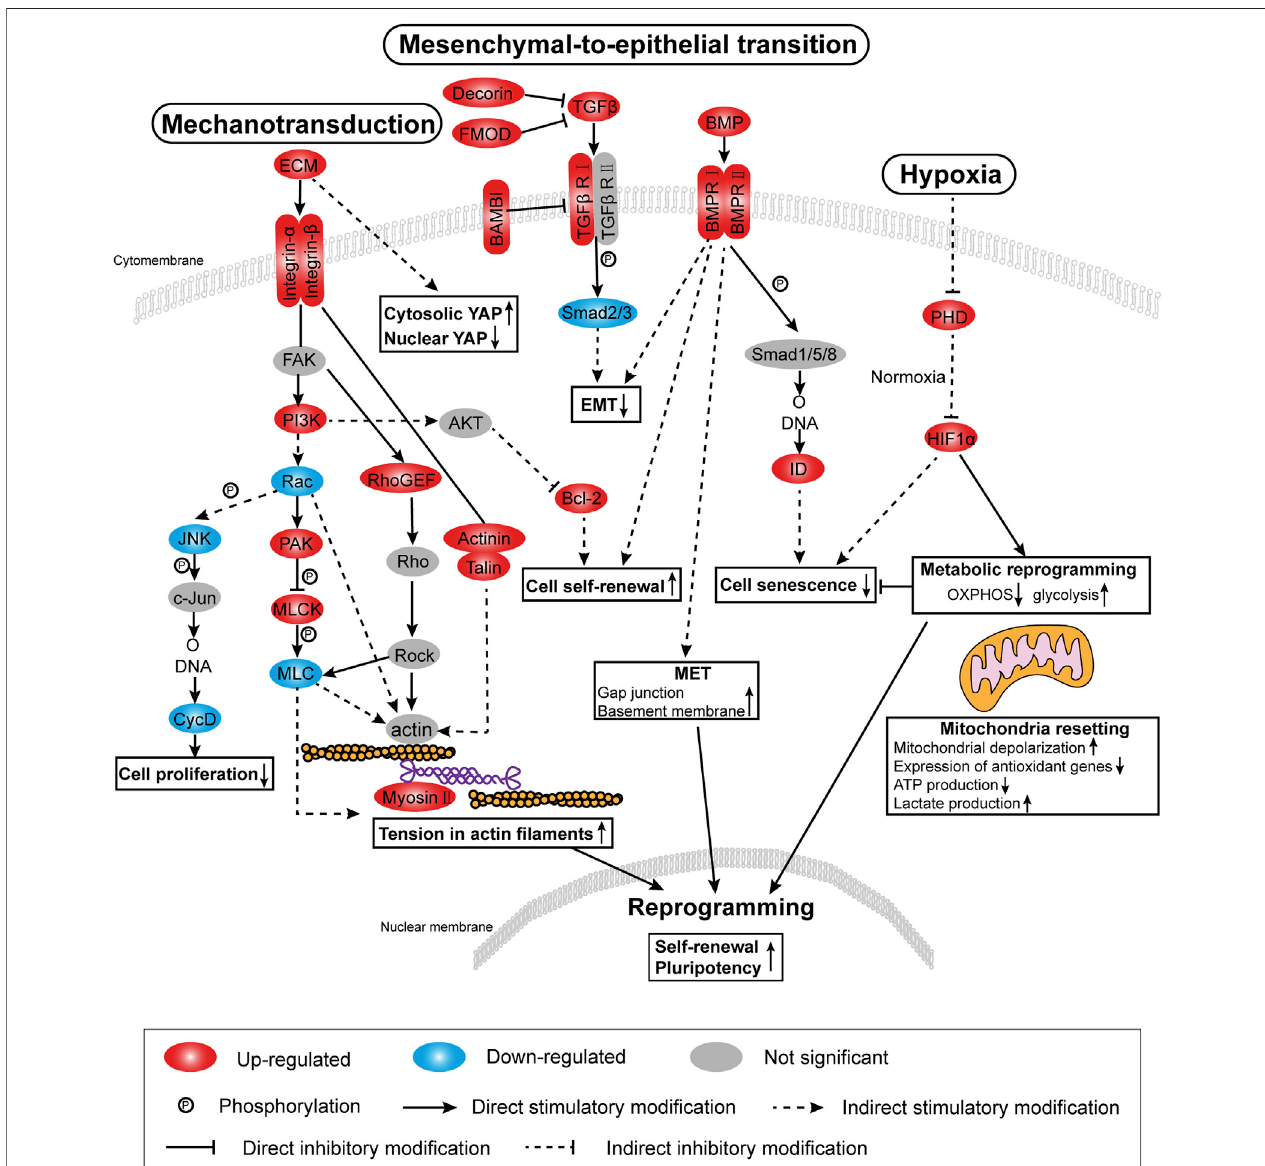
FIGURE 5 | Signaling pathway diagram based on RNA-seq analysis. According to DEGs, the KEGG mapper database and the literature, the diagram associated with facilitating reprogramming highlights mechanotransduction-related, mesenchymal-to-epithelial transition (MET)-related and hypoxia-related signaling pathways.